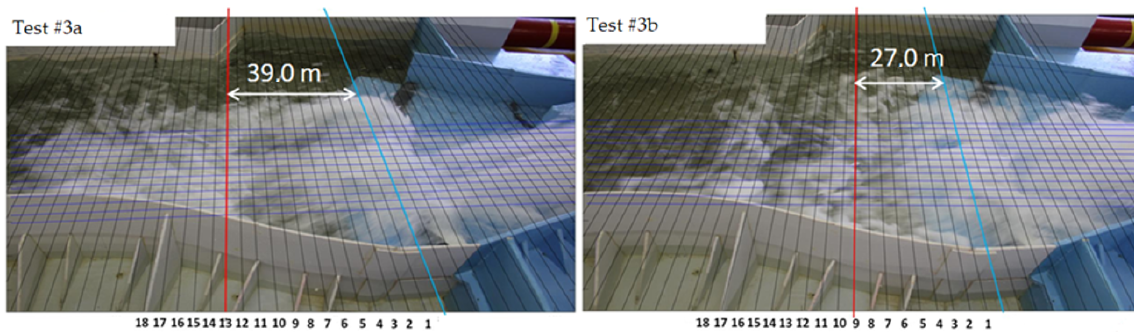
Figure 12. Hydrodynamics in the stilling basin and in the riverbed downstream from the lateral view for Test #3a (ski jump like sill in place) and Test #3b (ski jump like sill removed).